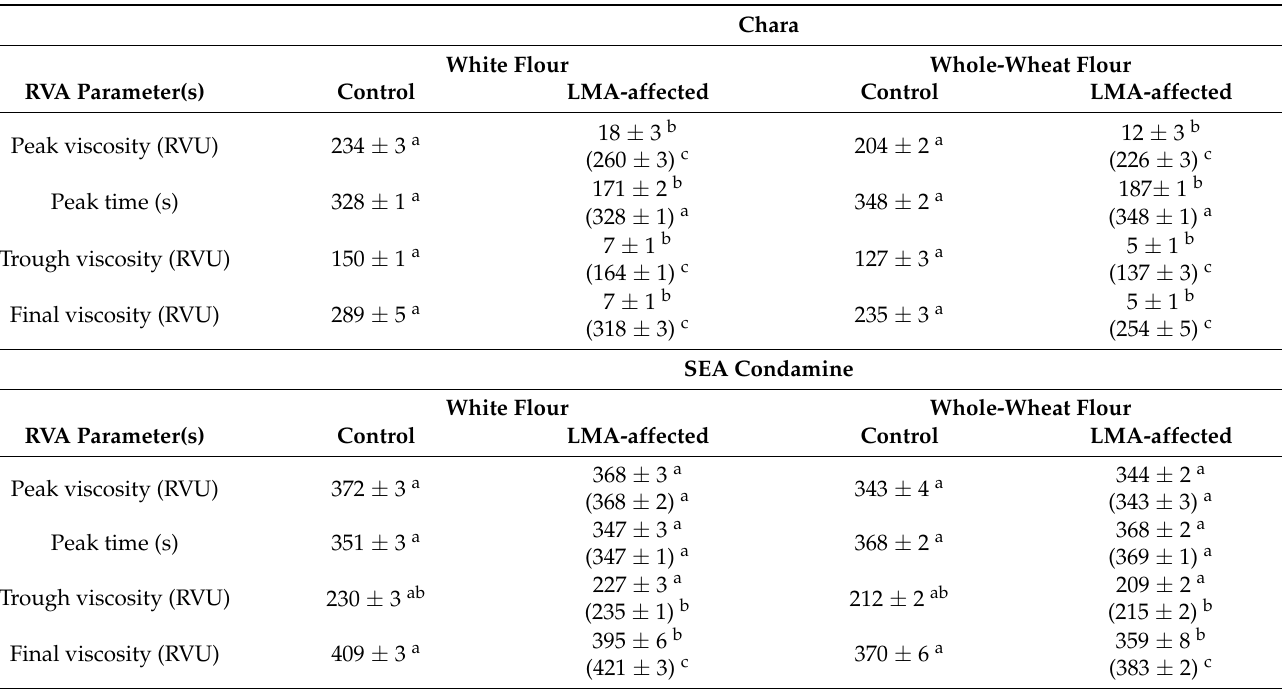
Values marked by different letters for the same cultivar within a row indicate significant differences ( p ≤ 0.05).